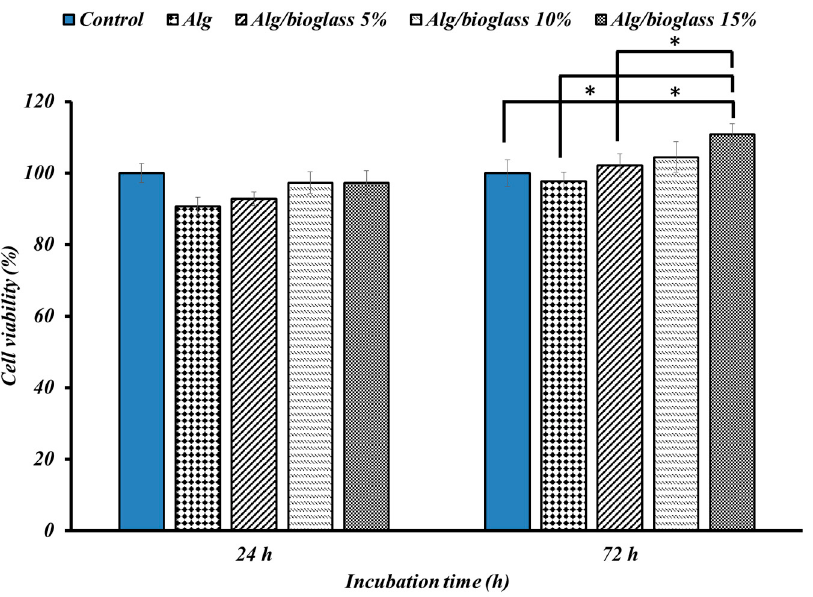
Figure 10. Cell proliferation as determined by MTT assay of MG-63 cells cultured in bioactive glass for 24 and 72 h. *: p < 0.05.